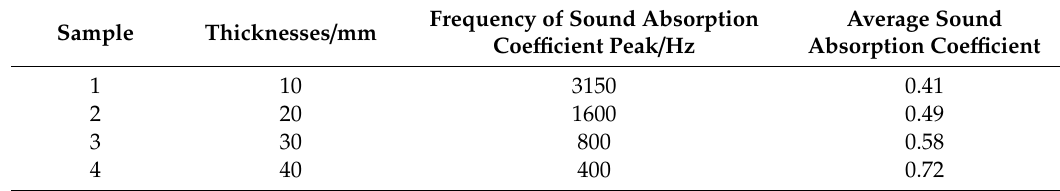
Table 2. Sound absorption parameters of specimens of different thicknesses.